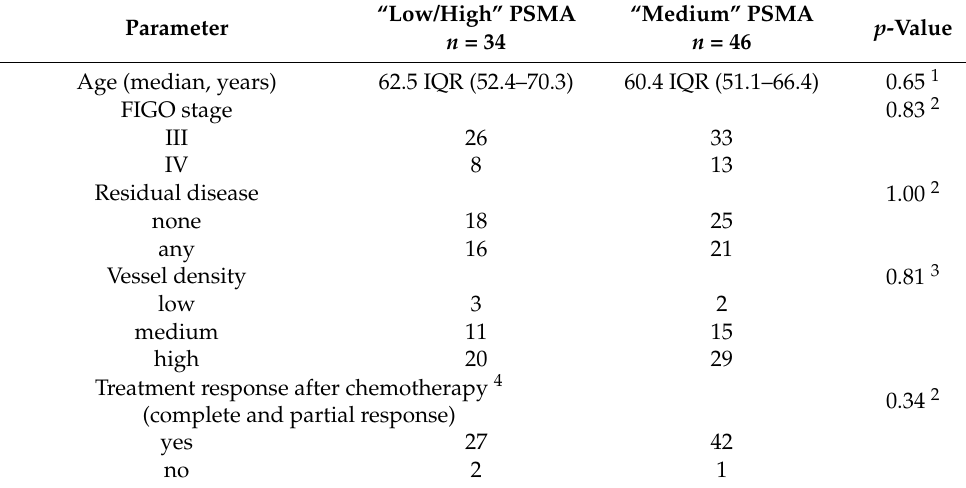
Table 1. Clinicopathological parameters in 80 patients with high-grade serous ovarian cancer stratified by PSMA expression.